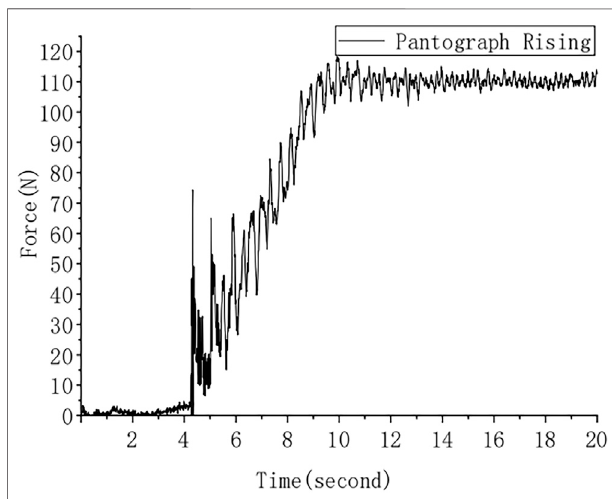
FIGURE 9 | Contact force of the elevation process.